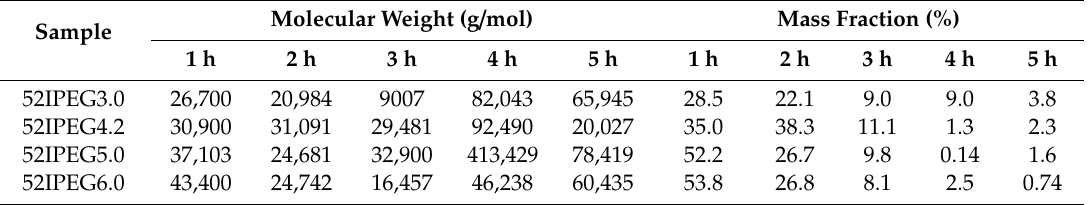
Table 2. Mass fraction of 52IPEGs with di ff erent molecular weights produced each hour.